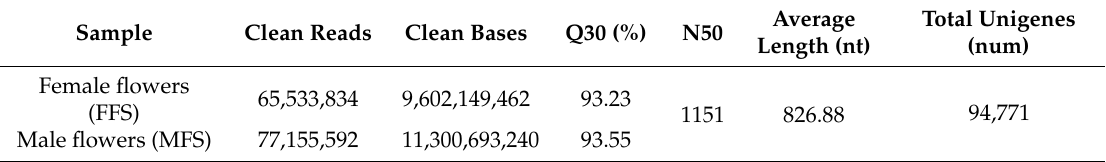
Table 1. Statistic for the result of de novo